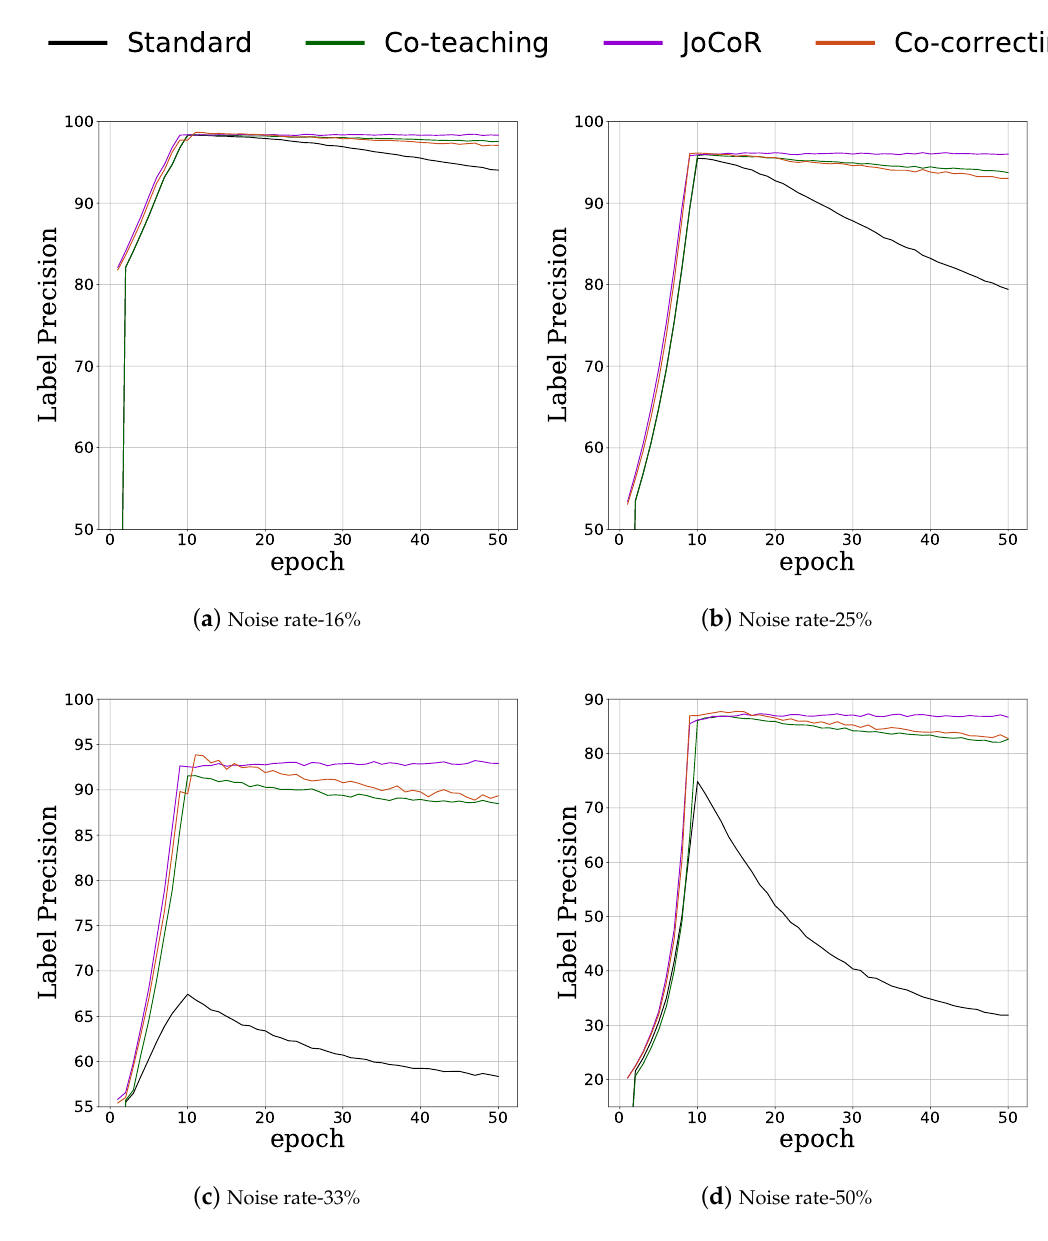
Figure 5. The label precision of the methods in Baselines . The training datasets have four different label noise rate: ( a ) noise rate 16%, ( b ) noise rate 25%, ( c ) noise rate 33% and ( d ) noise rate 50%. Higher label precision means less noisy samples are selected during sample selection, and methods with high label precision are more robust to noisy